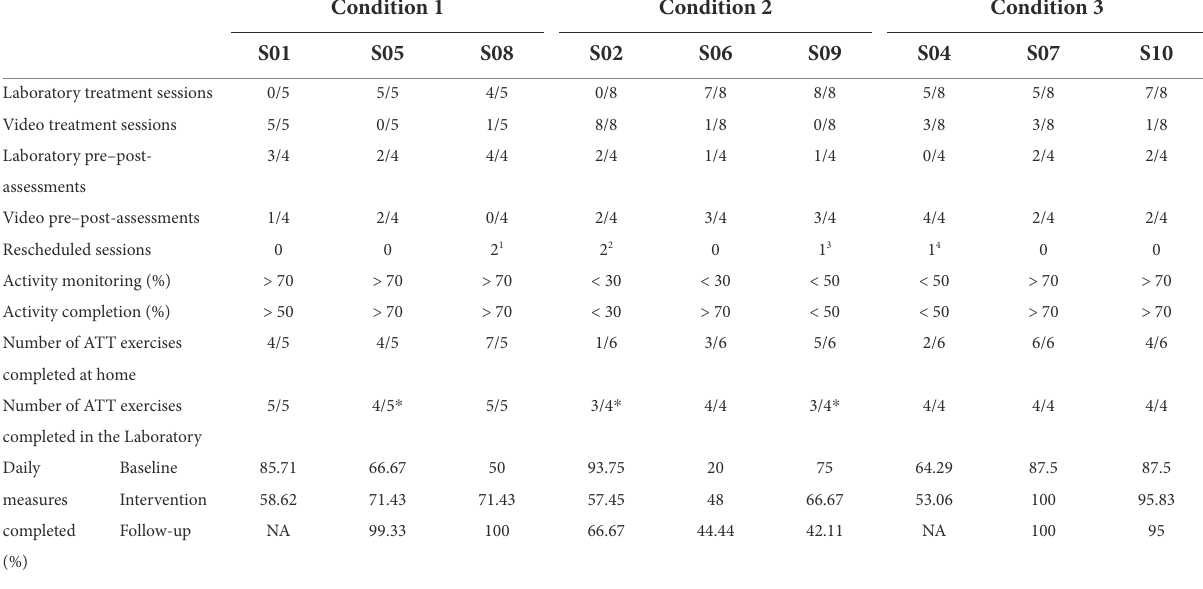
TABLE 3 Sessions attendance and homework